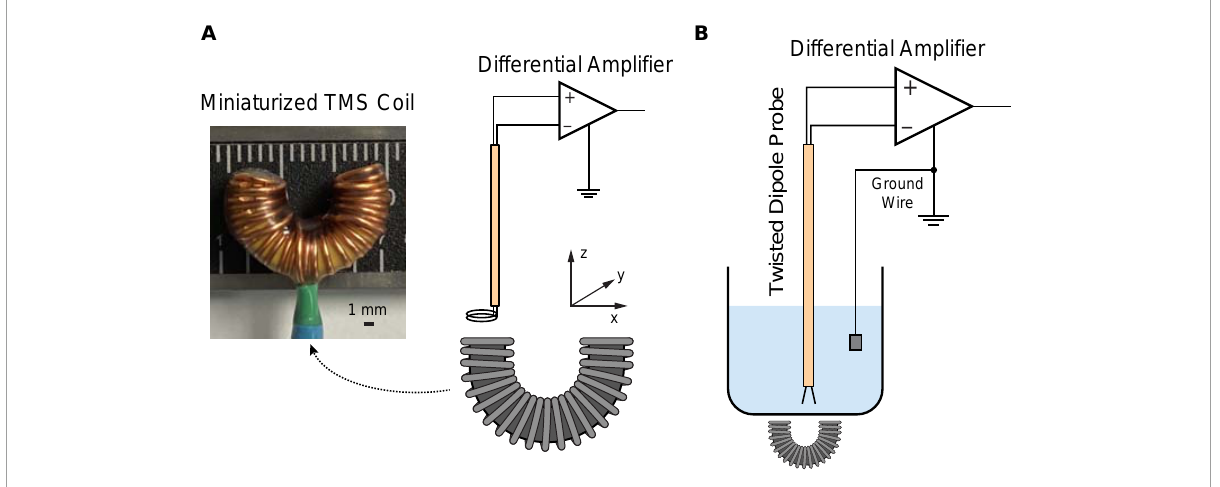
FIGURE1 Characterization of the miniaturized C-shaped coil. (A) Measure magnetic field via a two-loop search coil. (B) Measure induced electric field via a dipole probe in